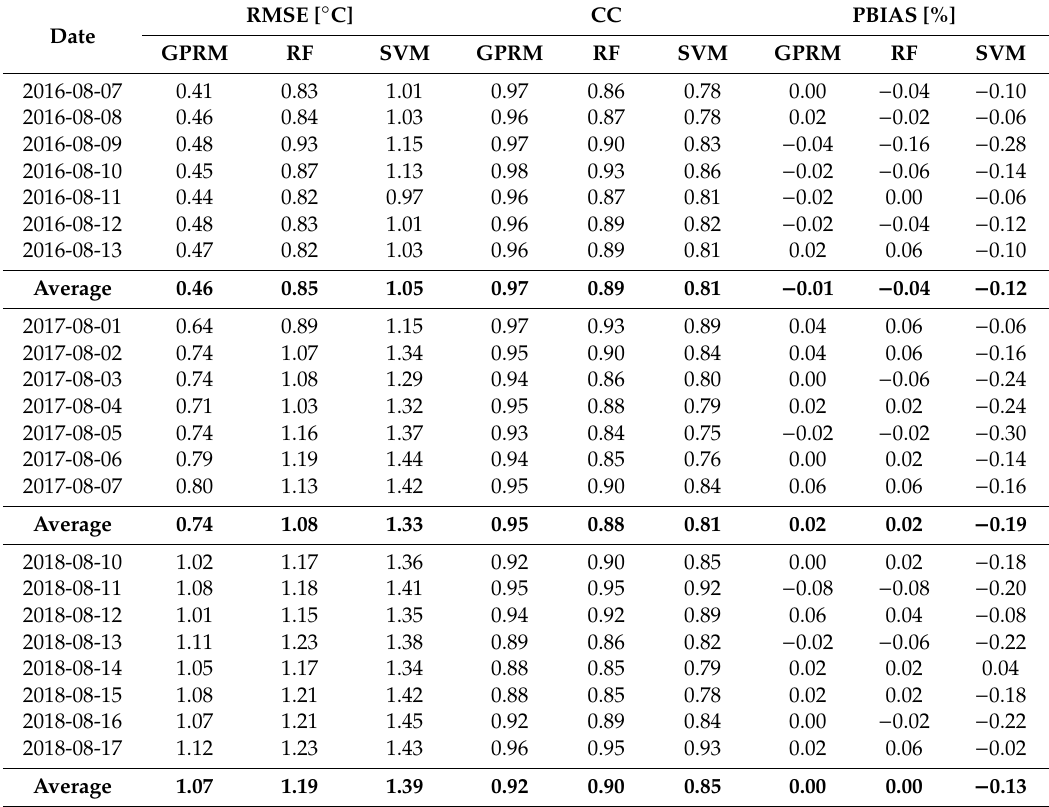
Figure 5. Daily minimum temperature on 2 August 2018, downscaled to a 1 km resolution: ( a ) SVM; ( b ) RF; and ( c ) GPRM. Units in the legend are degrees Celsius. Table 3. Cross-validation results via spatial prediction techniques applied to daily maximum